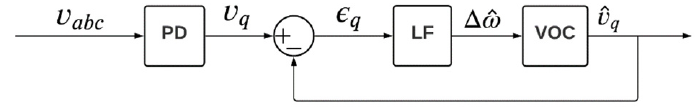
Figure 1. Basic diagram of a phase-locked loop (PLL).